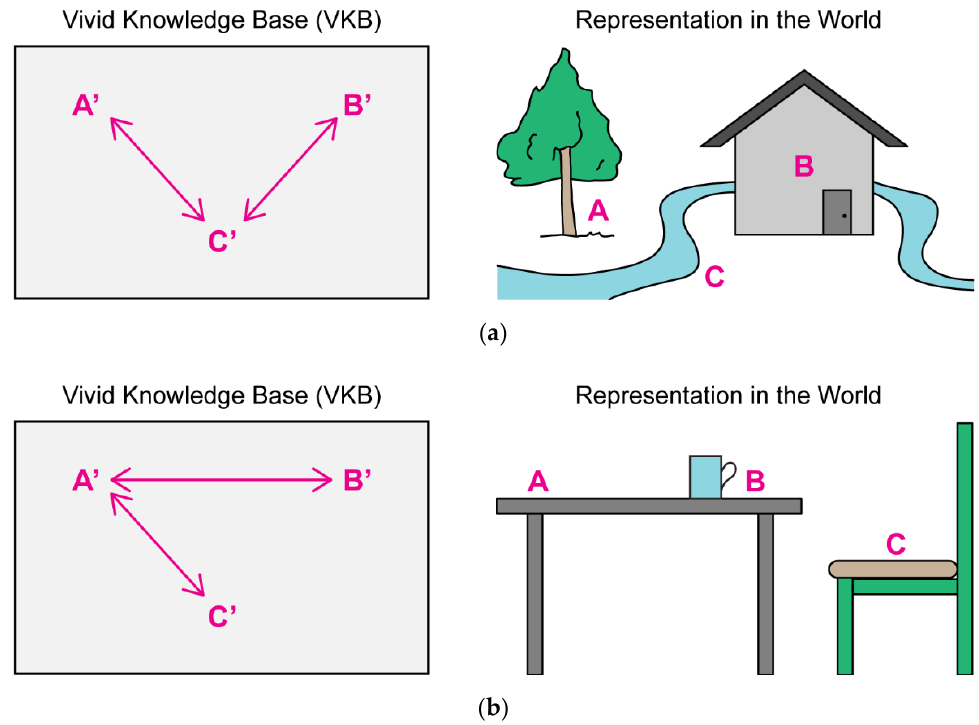
Figure 3. The computational definition of vividness from Brachman and Levesque [7] highlights the assumptions necessary for a KB to be considered vivid. It is understood that the KB assessing a world α operates under the “close-world assumption”—if something is not known to be true or to exist, it can be considered false or non-existent. Thus, a VKB will have as many representations as there are elements observed in a world α , no more, no less. For the elements that do exist in a world α , the KB will have representations with a one-to-one correspondence to each of those elements. If there exist any relationships between the elements in the world α that can be observed, the corresponding representations for those elements in the KB will also be connected. Any changes to the elements present in a world α will also be immediately reflected in the KB. ( a ) In the world, there exists a tree (A), a house (B), and a river (C). Both the tree and the house stand next to the river, but the house does not stand next to the tree. In the vivid knowledge base, there is a one-to-one representation of each of the elements found in the world (A’ is the representation of A from the real world, B’ represents B, C’ represents C). There are no more representations than there are elements to represent in the world (there exists no D’ in the VKB if there is no element D observed in the world). The relationship between each representation in the VKB reflects the relationship between the respective elements they represent in the world. For example, as the tree (A) stands next to the river (C), that relationship is also represented between A’ and C’ in the VKB. Conversely, since the tree (A) and the house (B) are not standing next to each other, there is also no relationship between A’ and B’ in the VKB. ( b ) In the world, there exists a table (A), a mug (B), and a chair (C). The mug stands on the table, and the chair is next to the table. In the vivid knowledge base, there is a one-to-one representation of each of the elements found in the world (A’ is the representation of A from the real world, B’ represents B, C’ represents C). There are no more representations than there are elements to represent in the world (there exists no D’ in the VKB if there is no element D observed in the world). The relationship between each representation in the VKB reflects the relationship between the respective elements they represent in the world. For example, as mug (B) sits on the table (A), that relationship is also represented between A’ and B’ in the VKB. Conversely, since the mug (B) is not standing on the chair (C), there is also no relationship between B’ and C’ in the VKB. Note that if there is a floor that the chair and table are standing on, it is not shown or observed by the KB, and thus it cannot be represented in